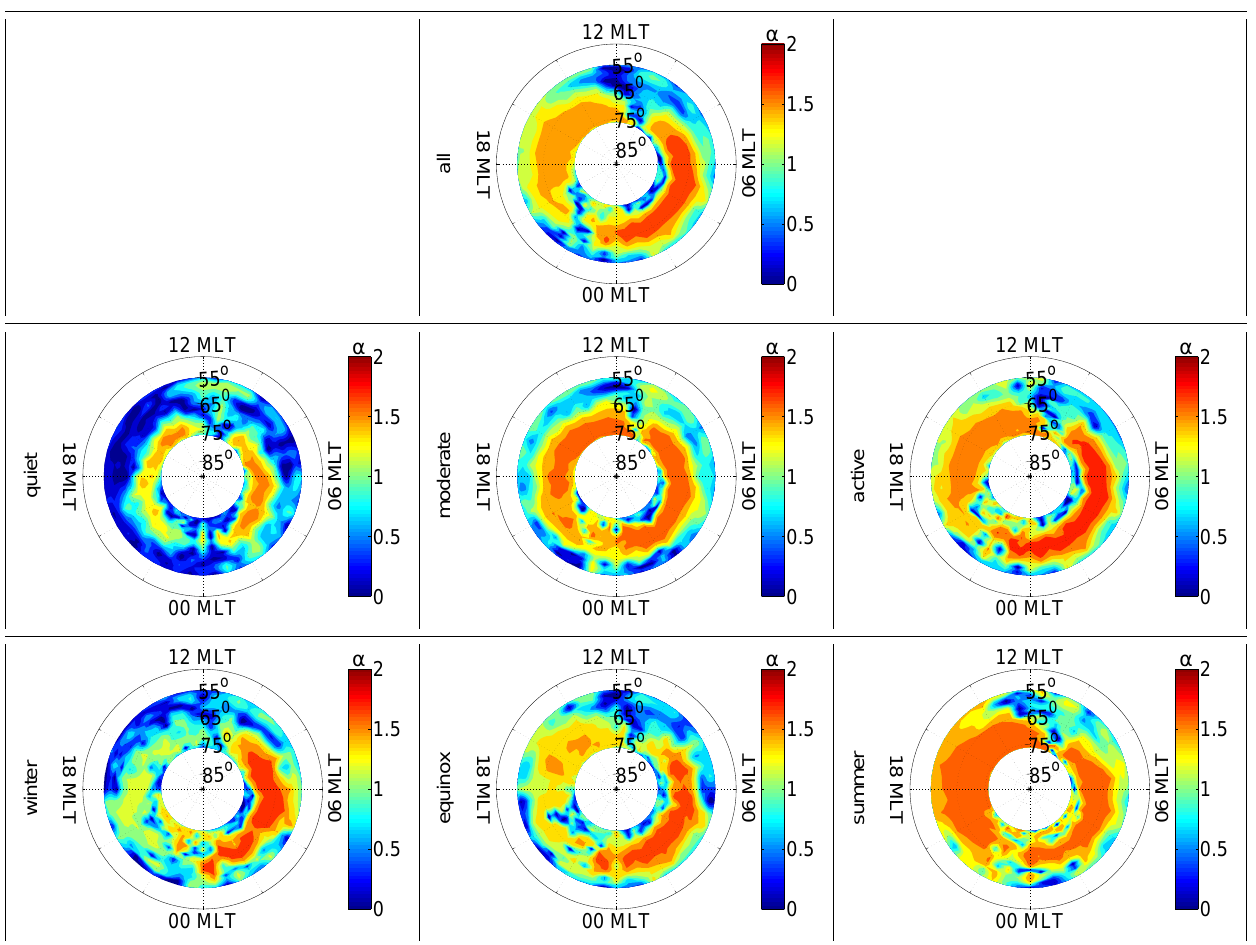
Fig. 15. Average α during 2001–2002 as a function of geomagnetic latitude and MLT. The resolution of the plots is 1 ◦ in latitude and 0 . 5h in MLT, and α is given according to the color bar on the right hand side of each plot. The maps have been determined from the φ component of the divergence-free current density (cf. J φ in Figs. 10 and 11) using Eq. (6) with C 1 and C 2 from Table 2. The upmost plot is constructed using all available data, the plots in the middle row are binned with respect to activity and those in the bottom row with respect to season (the bin is denoted on the left hand side of each plot).